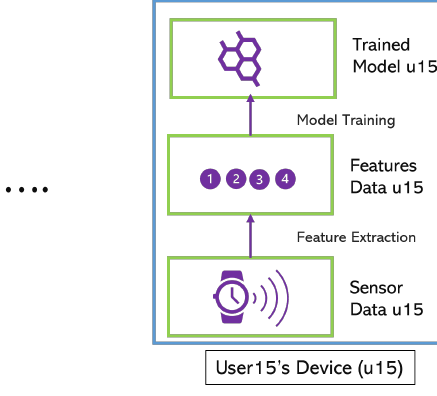
Figure 1. Individual Learning